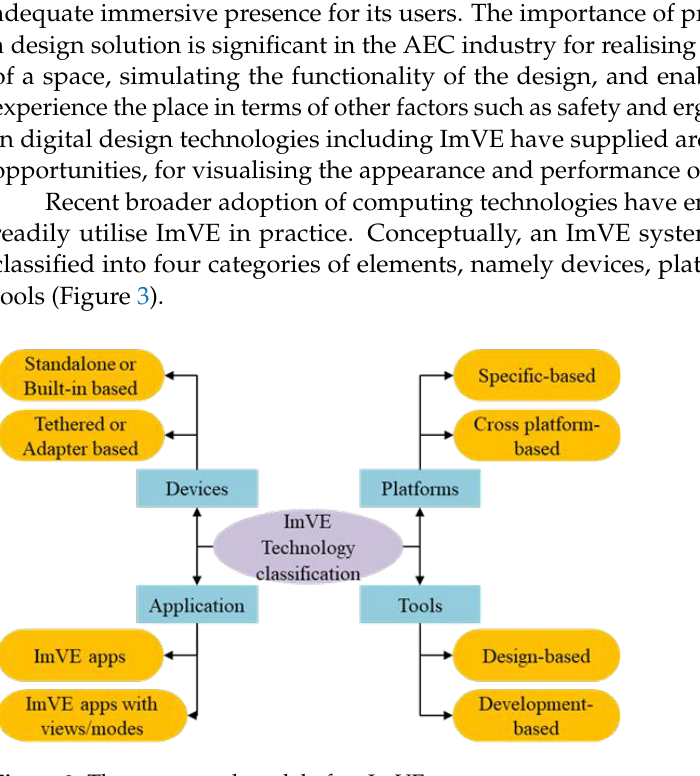
Figure 3. The conceptual model of an ImVE